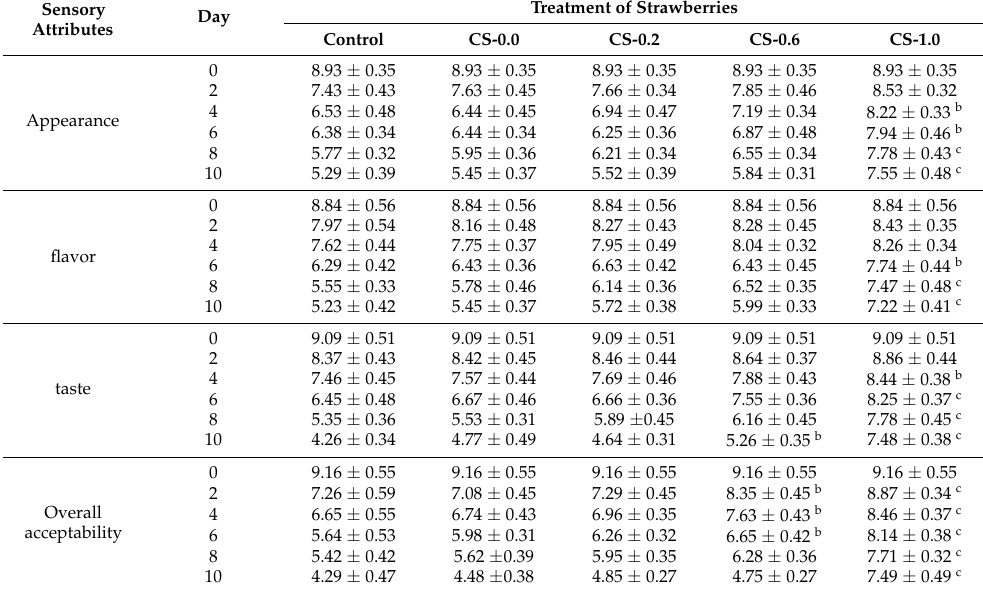
Table 5. The influence of CS films containing PFEO on the sensory attributes (appearance, flavor, taste, and overall acceptability) of strawberries refrigerated at 4 ◦ C for 10 days a